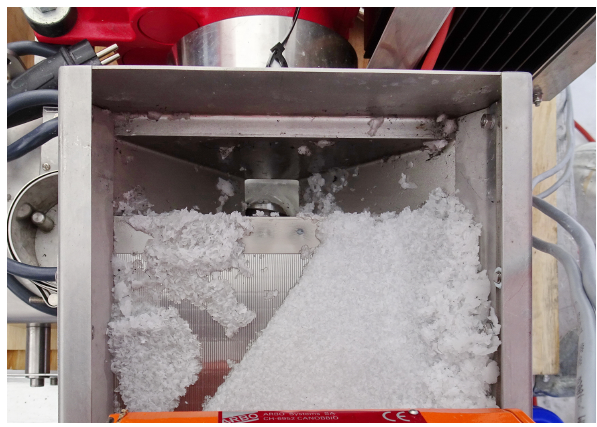
Figure 9. Top view of fluid–chip separation on a slotted wedge wire screen. The slurry is moving upwards on the vibrating screen and falls into the screw press